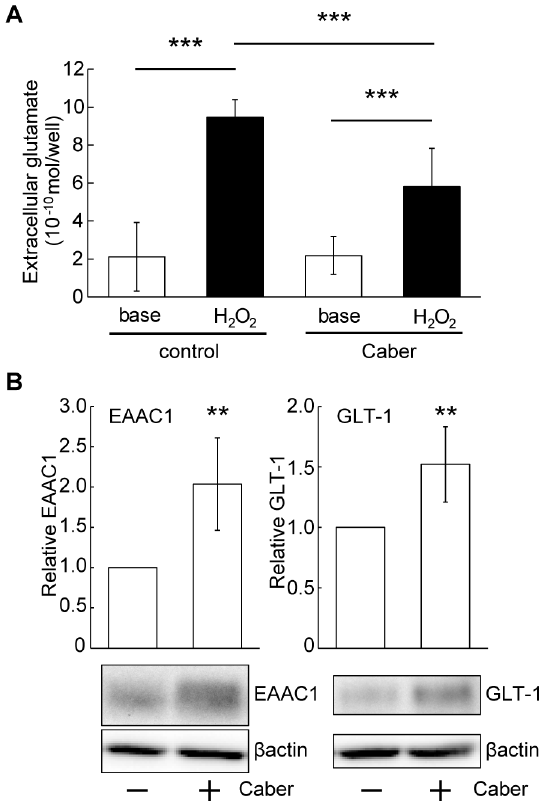
Figure 7. Cabergoline induced upregulation of glutamate transporters. (A) Pretreatment with cabergoline reduced H 2 O 2 - induced extracellular glutamate accumulation. Pretreatment with cabergoline was performed 24 hours before H 2 O 2 application. After the buffer was collected for measurement of basal concentrations, cells were exposed to buffer containing H 2 O 2 (50 m M) for 20 min. The data represent mean 6 SD (n=12, n indicates the number of wells per plate for each experimental condition). *** P , 0.001 (two-way ANOVA). (B) Cabergoline increased expression levels of glutamate transporters, EAAC1 and GLT-1. Total expression of EAAC1 and GLT-1 after cabergoline treatment for 24 hours. Uppe r: Quantification of EAAC1 and GLT-1 expression. All data represent mean 6 SD (EAAC1: n=6, GLT- 1: n=5). ** P , 0.01 vs. - Caber ( t -test).